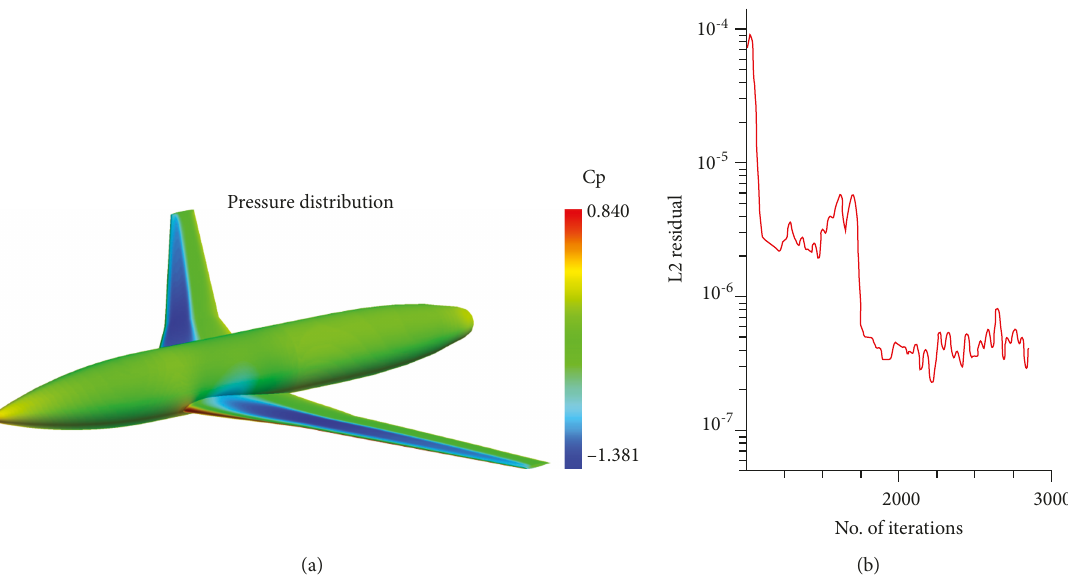
Figure 23: Cp distribution on ARA M100 wing-fuselage con fi guration. M = 0 8027 , α = 2 873 ° , and Re/m = 13 × 10 6 (a); convergence history (b).